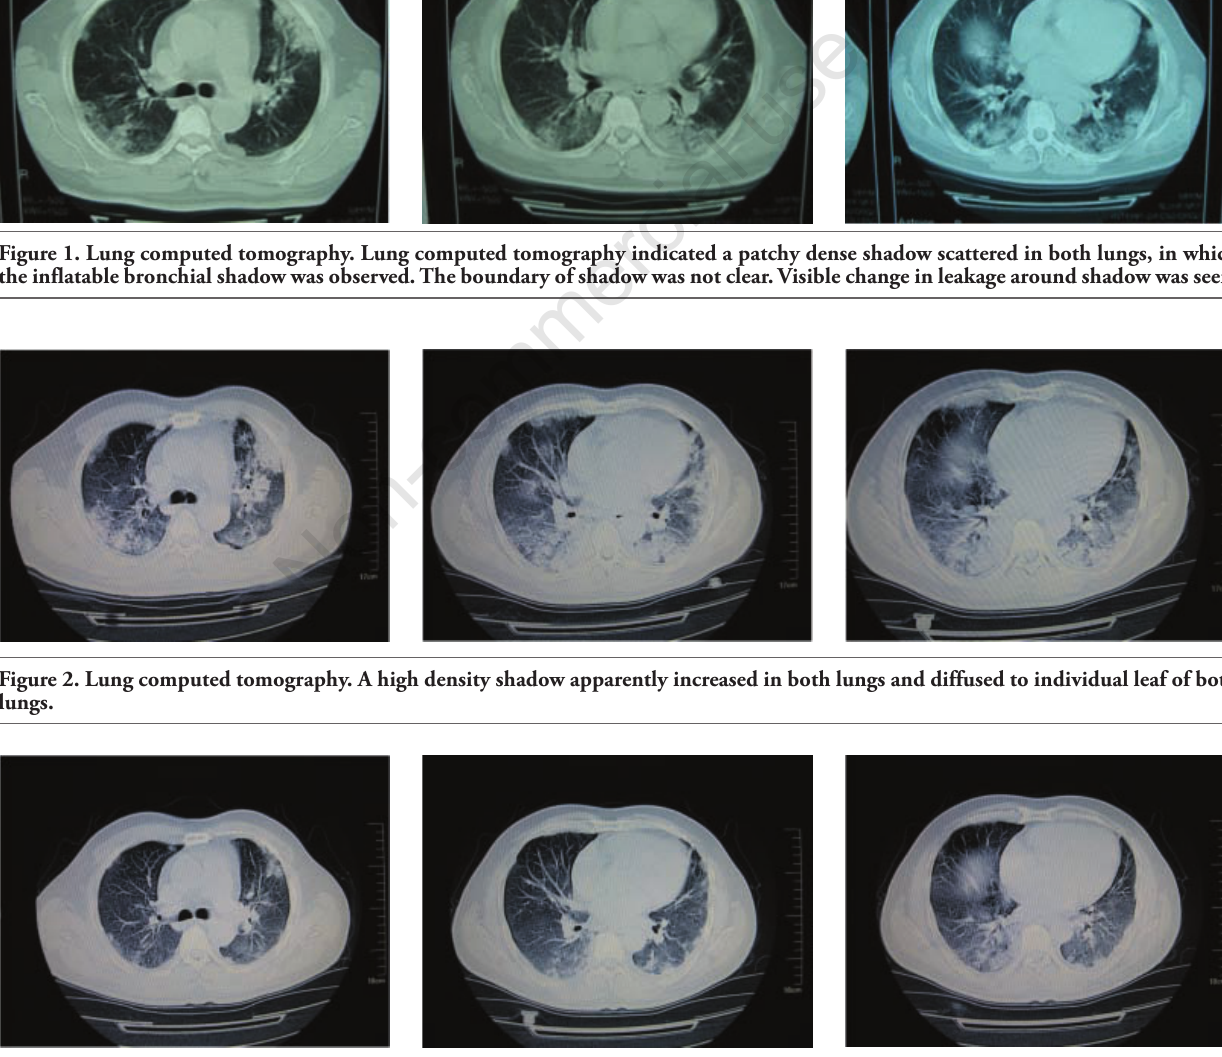
Figure 3. Lung computed tomography. Apparent absorption of lung